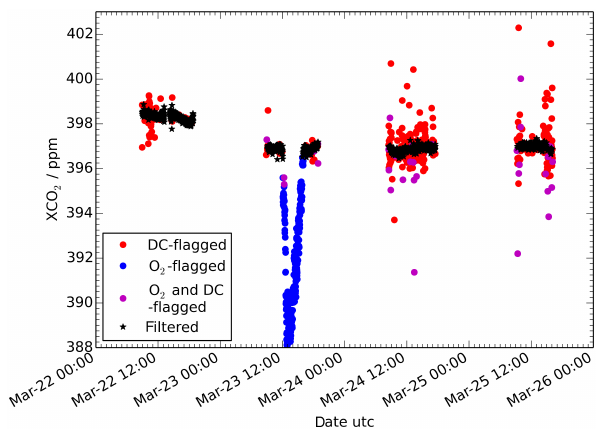
Figure 5. XCO 2 (top) record for a representative day after apply- ing the DC and O 2 quality filters. The XCH 4 (upper middle, red) and O 2 (lower middle, blue) retrievals indicate no enhancements. In contrast, the XCO 2 enhancement of more than 2ppm between 3 and 5p . m . can be related to the lines of sight crossing the ship’s ex- haust plume. The calculated enhancement E los (bottom) drives the EP filter with a rejection threshold set at